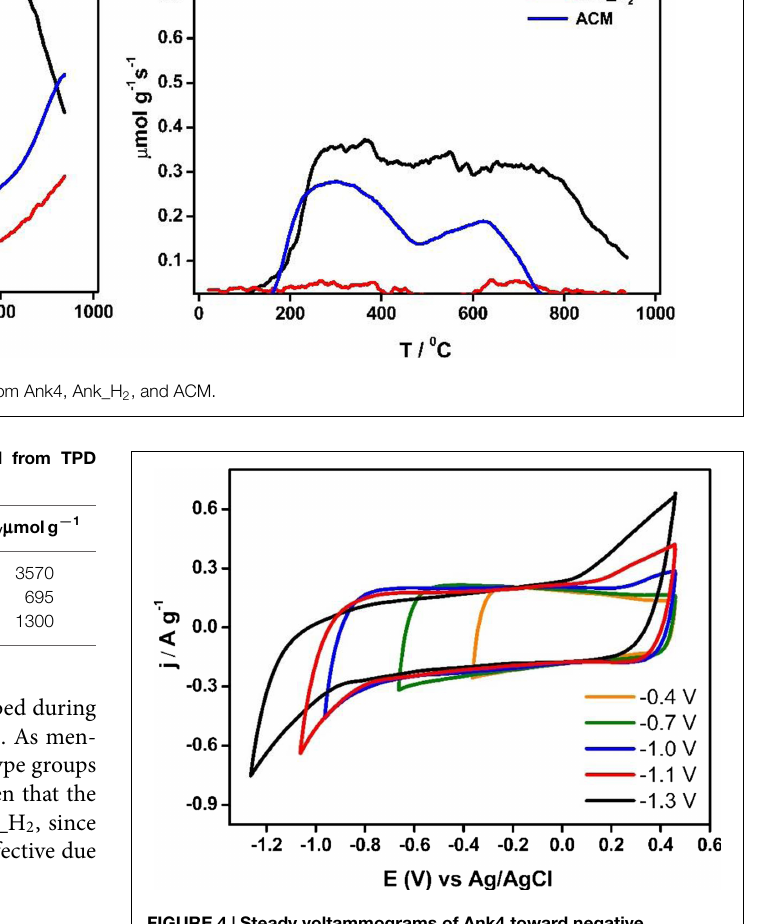
material reaches further negative potential values (Leyva-García et al.,